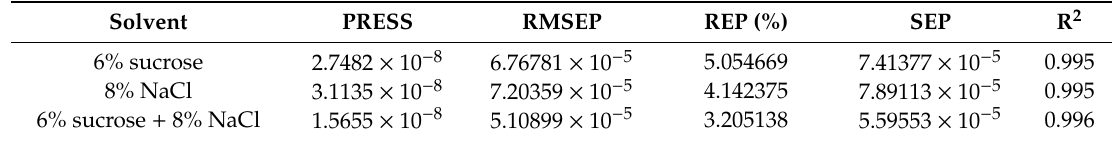
Table 7. Results of statistical parameters of the Apelblat equation.